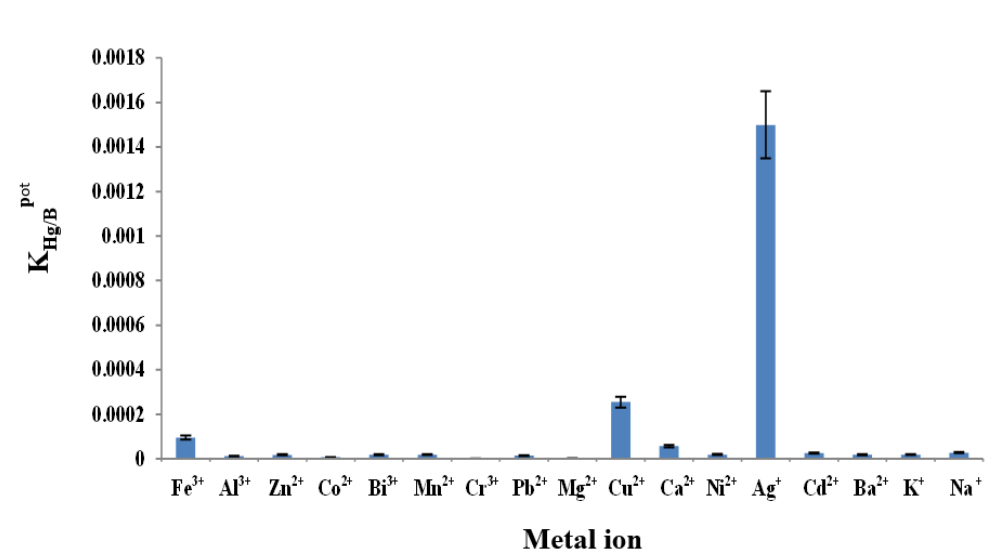
Figure 10. The values of 𝐾 𝐻𝑔,𝑀𝑝𝑜𝑡 of proposed Hg 2+ –SE for variety of different